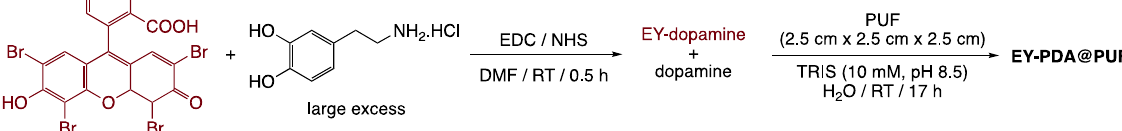
Figure 11. GC conversions measured over fi ve successive runs of thioanisole oxidation photocata- lyzed by a single sample of EY-PDA@PUF. Reaction conditions: thioanisole (0.5 mmol), EY- PDA@PUF (2.5 cm × 2.5 cm × 2.5 cm), CH 3 CN/H 2 O (4:1) (20 mL), 24 W white LED, O 2 balloon, 30–35 °C due to LED light heat, 1000 rpm. Compared with the previously reported supported EY catalysts [8,16,20,22–32], the stabilities of all our macroscopic PDA@PUF supported catalysts are disappointing, sug- gesting that PDA may not be an ideal support matrix for eosin Y as non-negligible simple adsorption relative to the expected covalent grafting on the la tt er seems to have occurred in all of the investigated cases. 3. Experimental Section 3.1. Materials and Methods Unless otherwise stated, all reagents and solvents were used as provided by com- mercial suppliers without any further puri fi cation/treatment. Polyurethane open cells foams (20 PPI, TCL 40100 soft white reticulated) were given by FoamPartner. Eosin Y (T0035) and 4-(methylthio)toluene (M0949) were purchased from TCI. Dopamine hydro- chloride (008896), EDC hydrochloride (024810), N-hydroxysuccinimide (005022), 3-